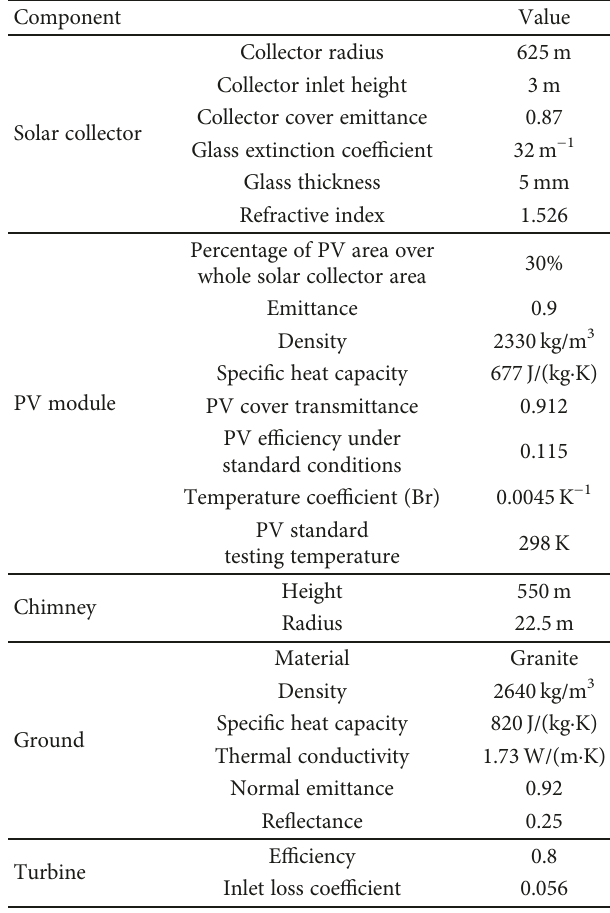
Table 2: Con fi guration sizes and coe ffi cients of the